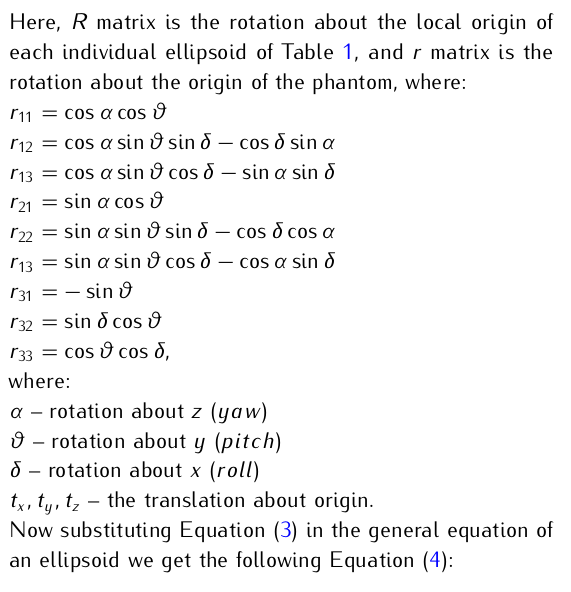
Figure 3. Projections at different source positions: (a–d) β = 0°, 90°, 135°,